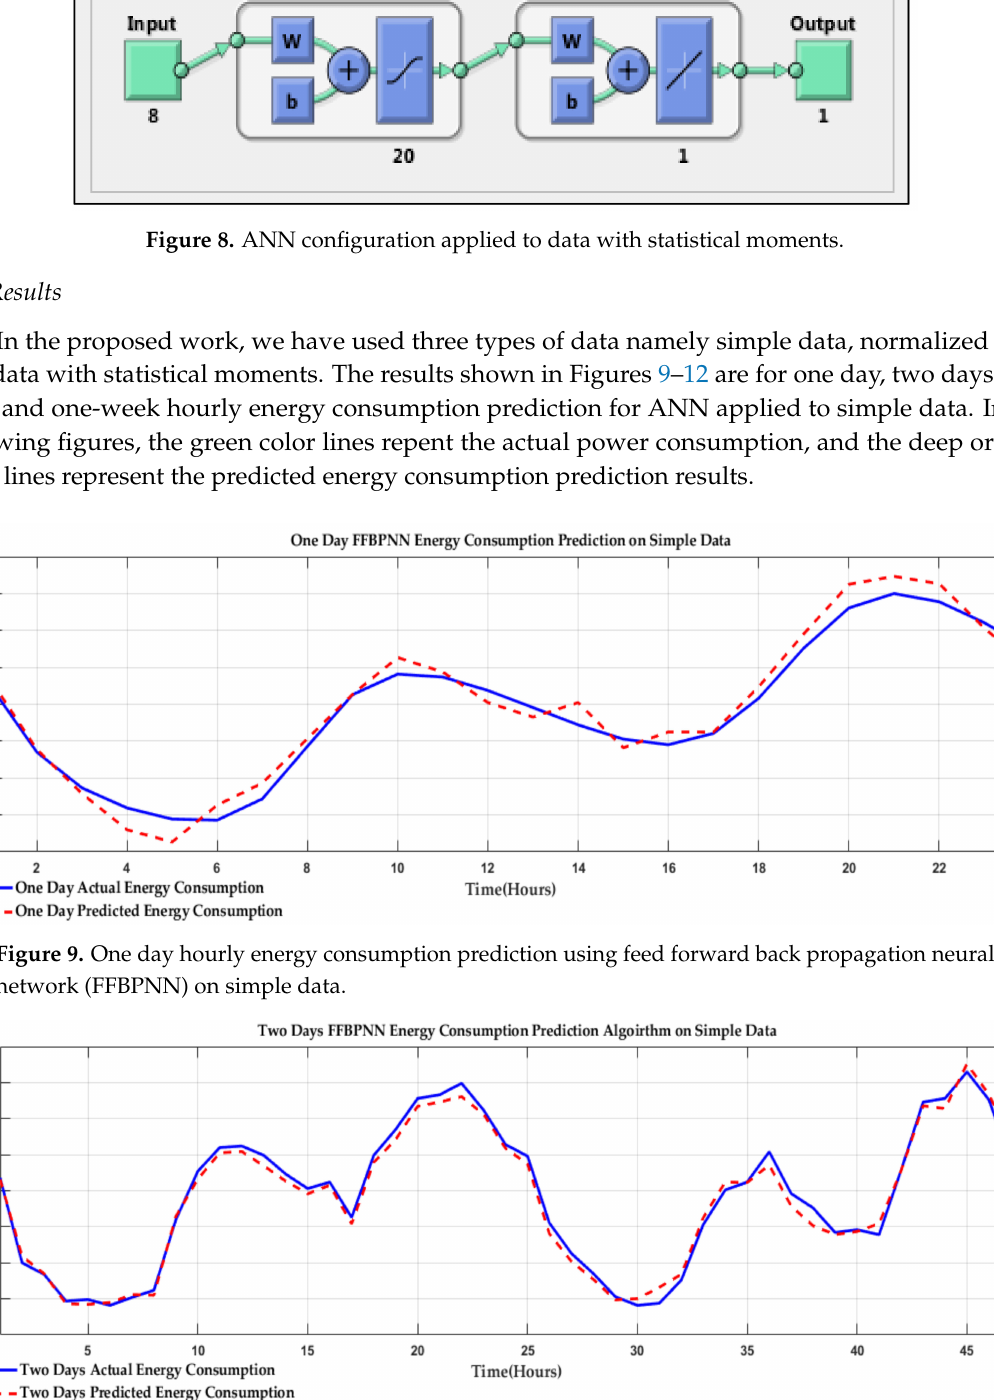
Figure 10. Two days of hourly energy consumption prediction using FFBPNN on simple